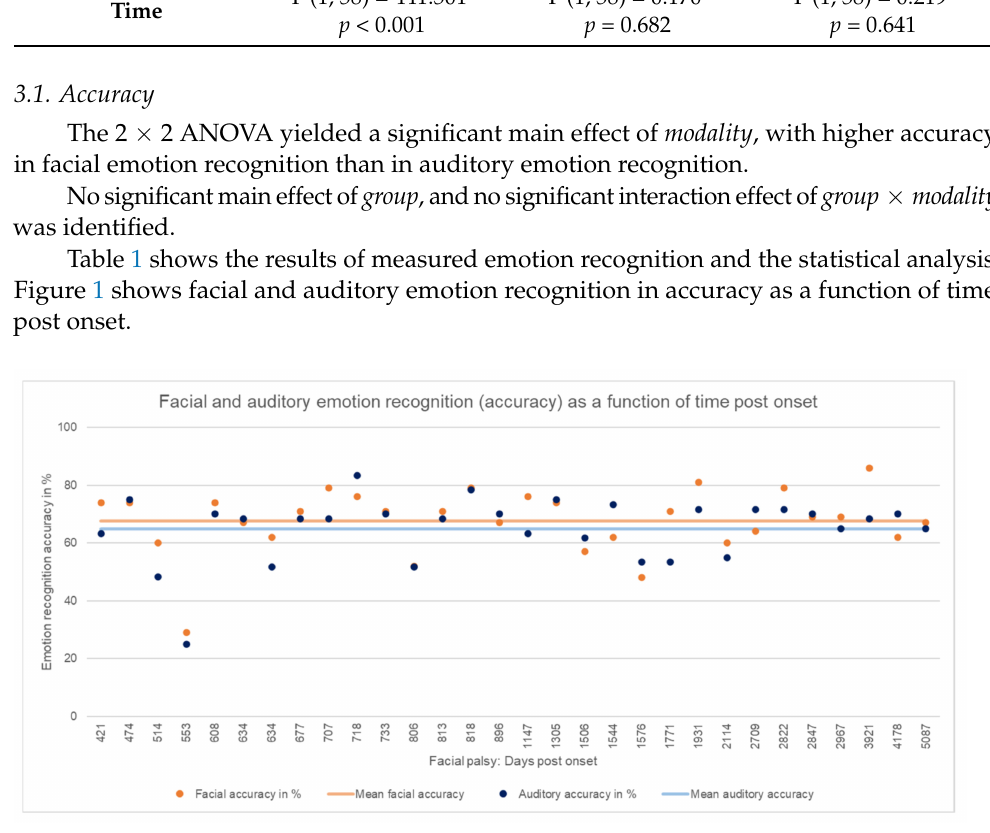
Figure 1. Facial and auditory emotion recognition (accuracy) as a function of time post onset. Individual results of the patients with facial synkinesis are shown as dots in bright orange (facial accuracy) and bright blue (auditory accuracy). Mean of facial accuracy in the patient group is shown as a line in pastel orange, and mean of auditory accuracy in the patient group is shown as a line in pastel